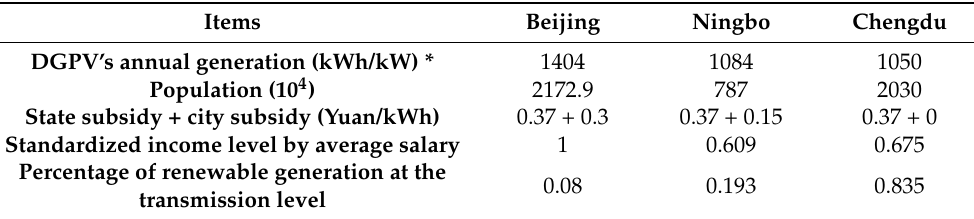
Table 12. Difference of three city ADNs.